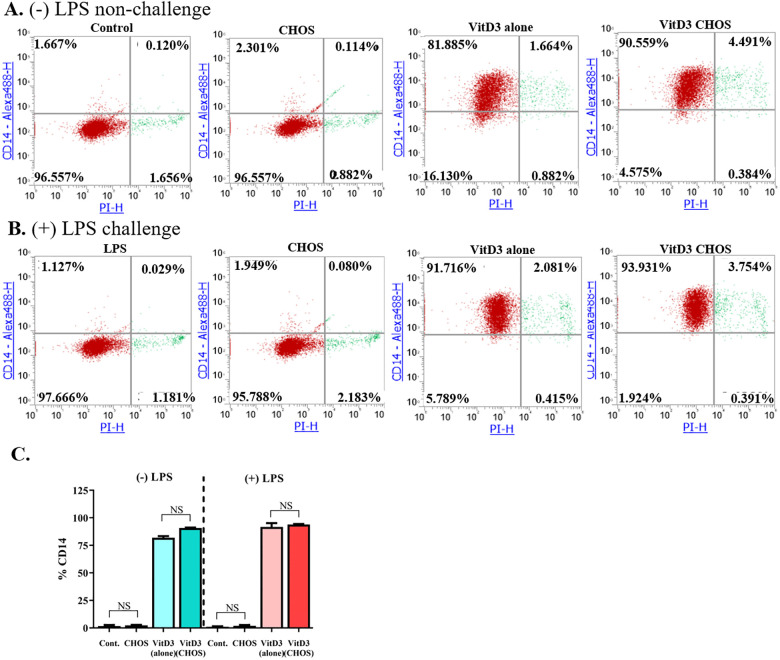
The effect of CHOS and LPS on CD14 expression and viability in THP-1 cells.Both non-differentiated and VitD3 differentiated THP-1 cells were treated with 100 μg/mL of CHOS and 100 ng/mL of LPS. Flow cytometry was used to determine CD14 expression and PI staining. Panels (A) and (B) show flow cytometry dot plots for representative experiments. The bar chart (C) is generated from the average of data from the upper-left quadrant of three independent experiments. The data represent three independent duplicated experiments (n = 6). NS means non-significant.